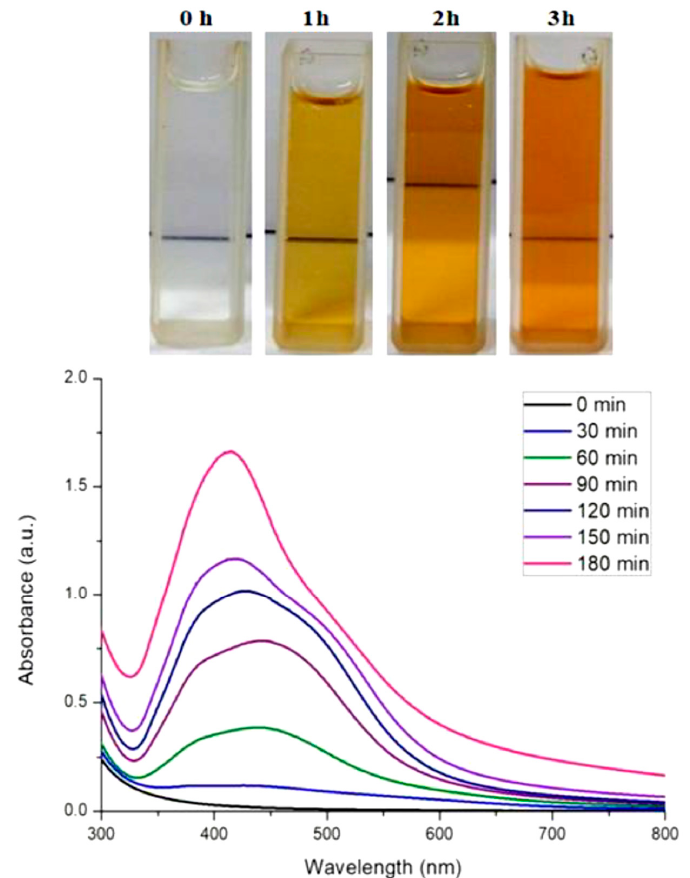
Figure 1. Showing the color change of reaction mixture from light to dark brown indicated the formation of AgNPs and UV-Vis spectra confirmed the time dependent biosynthesis of AgNPs.